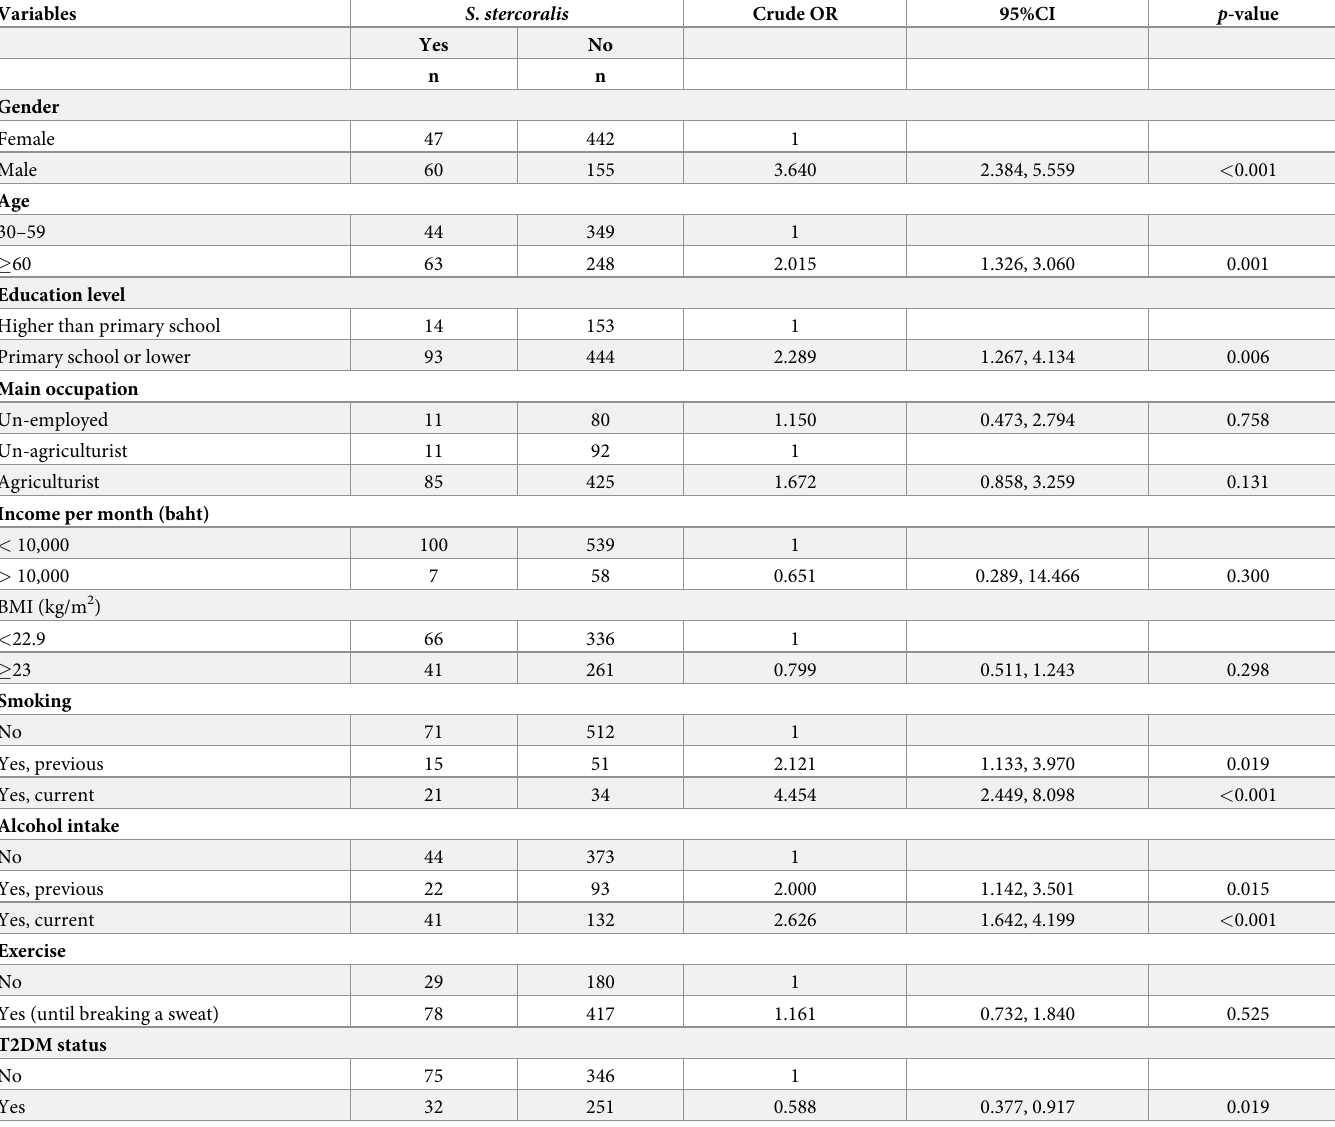
Table 2. Univariable logistic regression analyses of the association between demographic characteristics, socioeconomic factors and S . stercoralis infection ( n = 704).